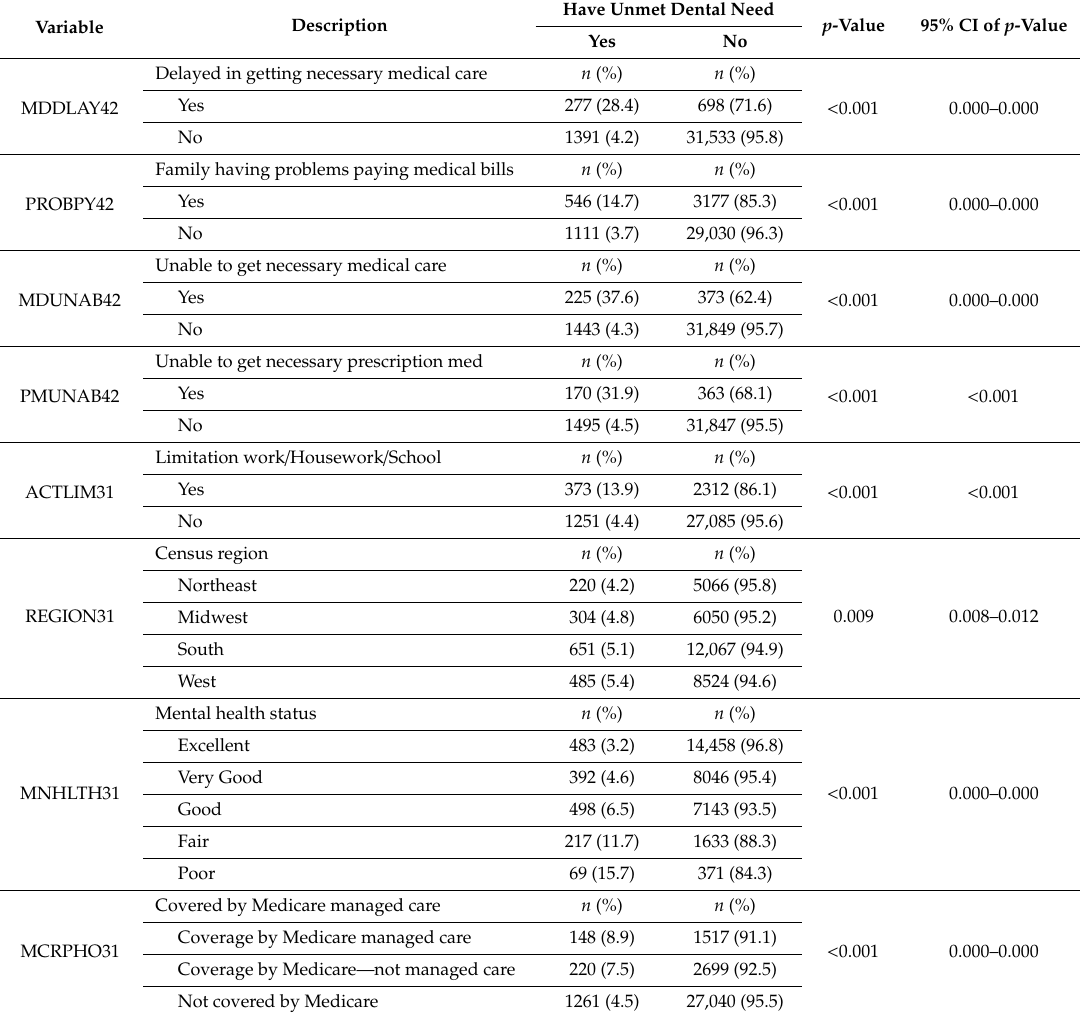
Table 3. Top predictors of unmet dental care